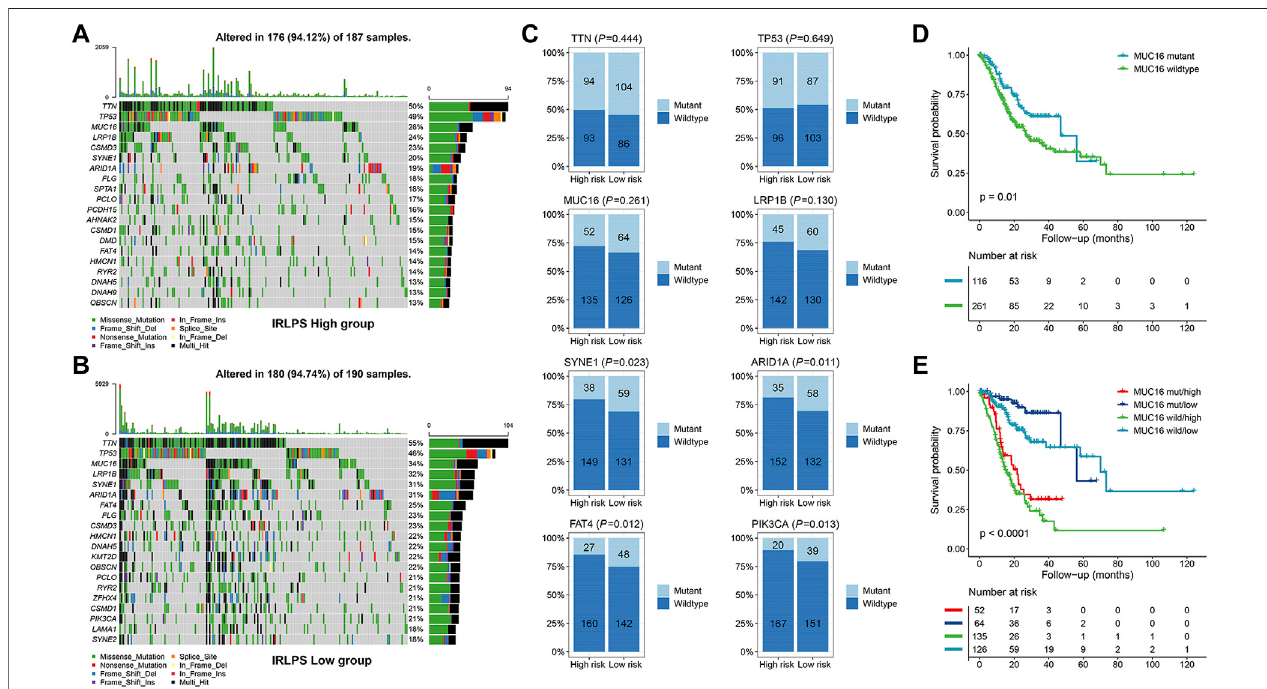
FIGURE 6 | Comparisons of the somatic mutations between the high- and low-risk groups of the TCGA cohort. (A,B) Waterfall plot displayed the top 20 mutated genes in the high- and low-risk groups, respectively; (C) Comparisons of the mutation status of TTN , TP53 , MUC16 , LRP1B , SYNE1 , ARID1A , FAT4 , and PIK3CA between the high- and low-risk groups; (D) Kaplan-Meier curve analysis of the overall survival (OS) strati fi ed by the MUC16 mutation status; (E) Kaplan-Meier curve analysis of the OS according to both the MUC16 mutation status and our prognostic signature.